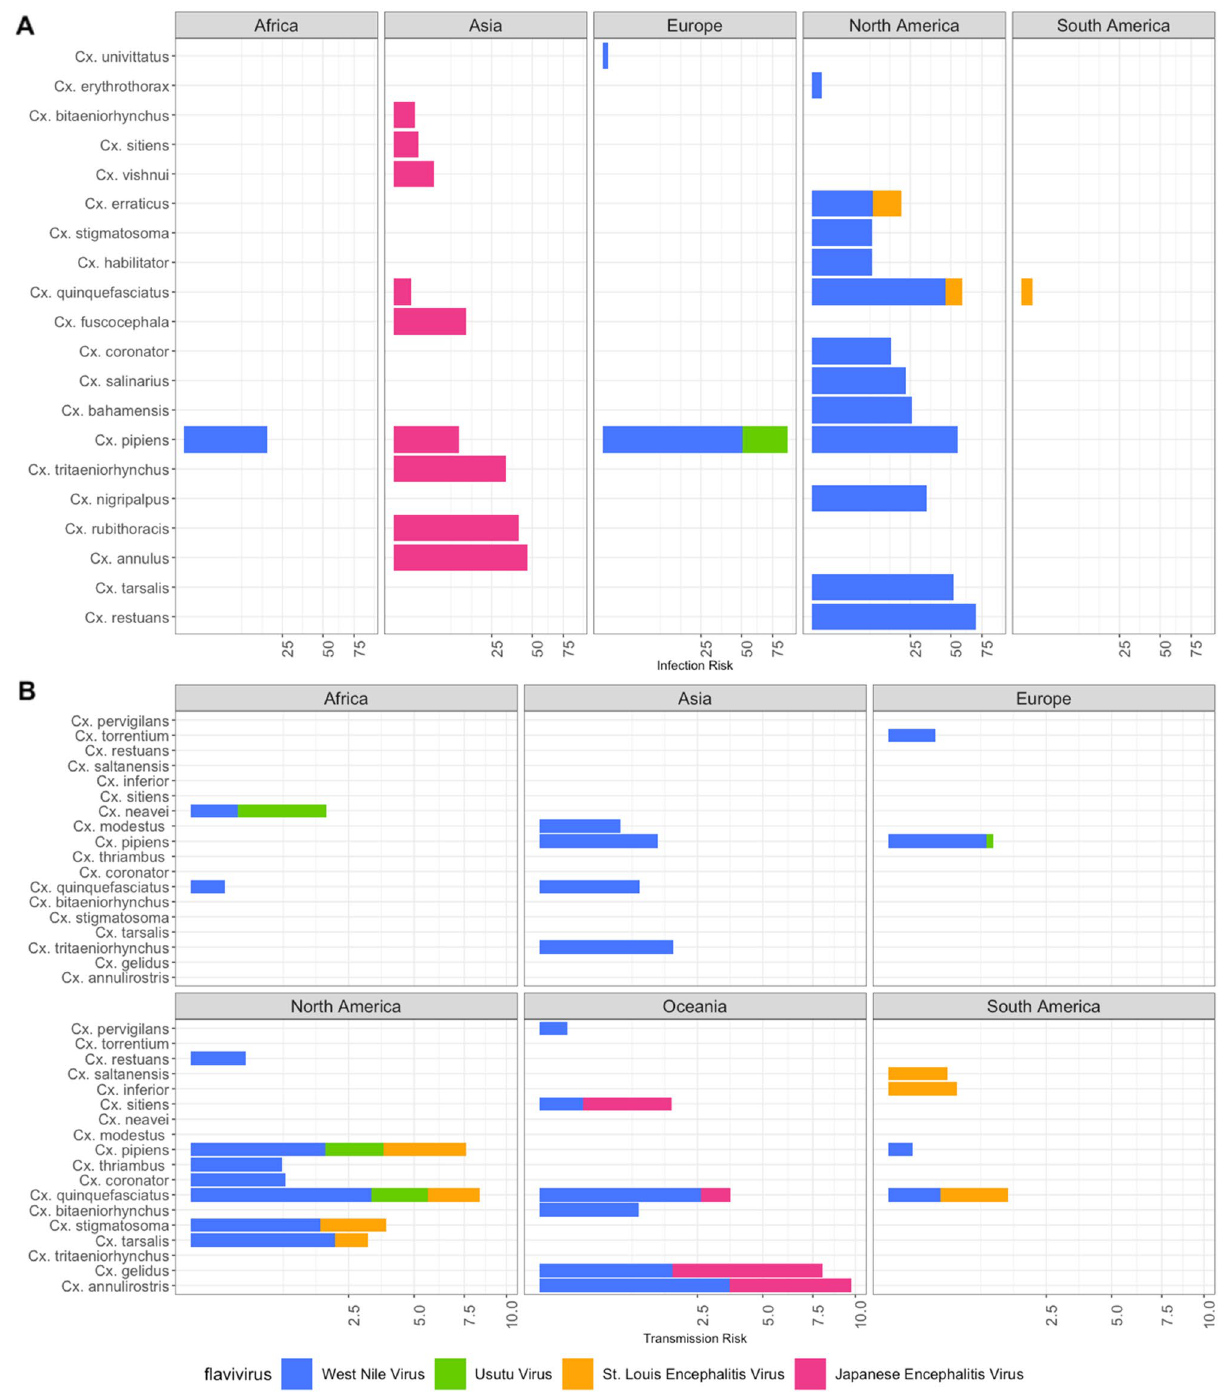
Figure 3. JES ( A ) Infection Risk and ( B ) Transmission Risk by mosquito